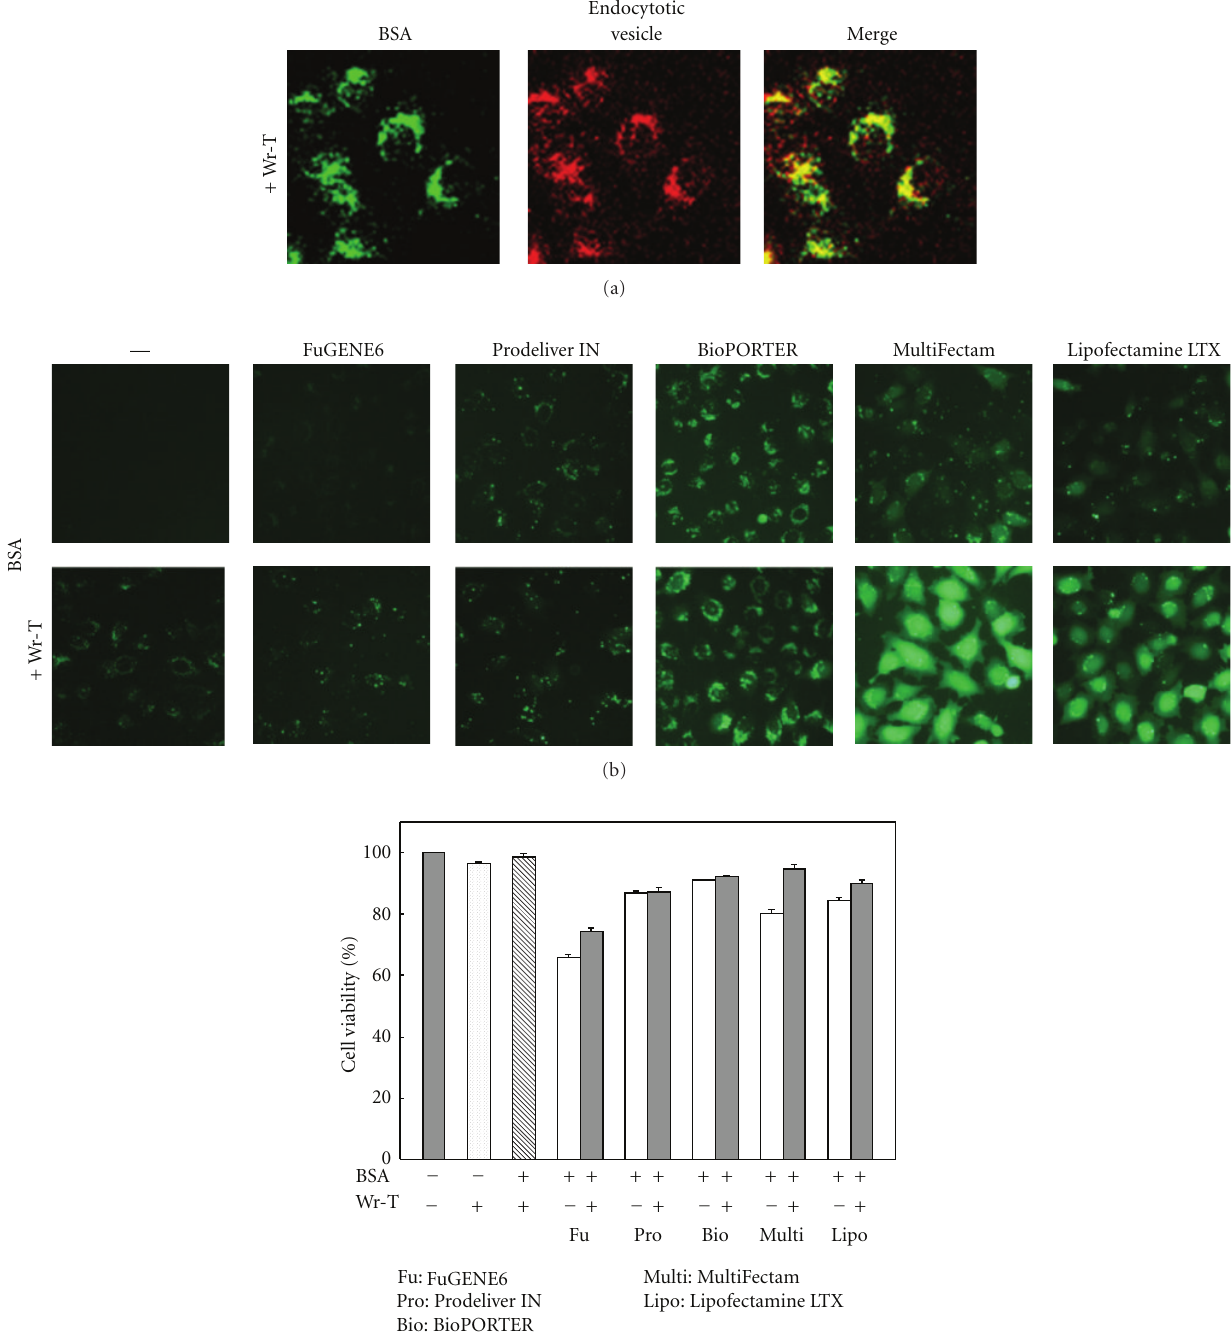
Figure 1: Wr-T/cationic lipid reagent mixture-mediated delivery of BSA proteins into living cells. (a) Cellular localization of Wr-T/BSA complexes. The internalization of Alexa-488-labeled BSA protein and marker dyes for endocytotic vesicles into HeLa cells was analyzed by confocal laser scanning microscopy. (b) Functional properties of Wr-T/cationic lipid reagents mixture pertaining to protein transduction. HeLa cells were cotreated by BSA with Wt-T and cationic lipid reagents in serum-free medium. After incubation for 3 h, the cells were placed in fresh medium and assessed at the same exposure time by fluorescence microscopy. (c) Cytotoxicity of Wr-T/cationic lipid reagent/cargo protein mixture. HeLa cell viability was quantified by the amount of ATP derived from metabolically active cells. Data were consistent in two repeat